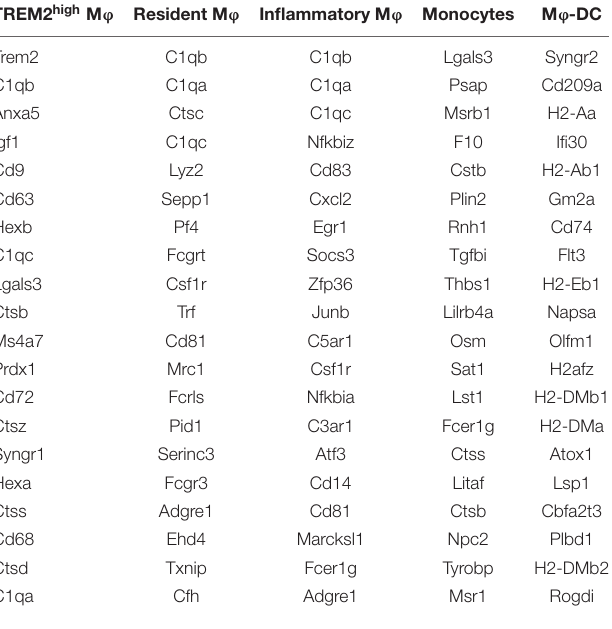
compared with normal control in each cluster. The heatmap of genes in each M ϕ population vs. the four others as determined by single-cell differential expression analysis is shown in Figure 1B